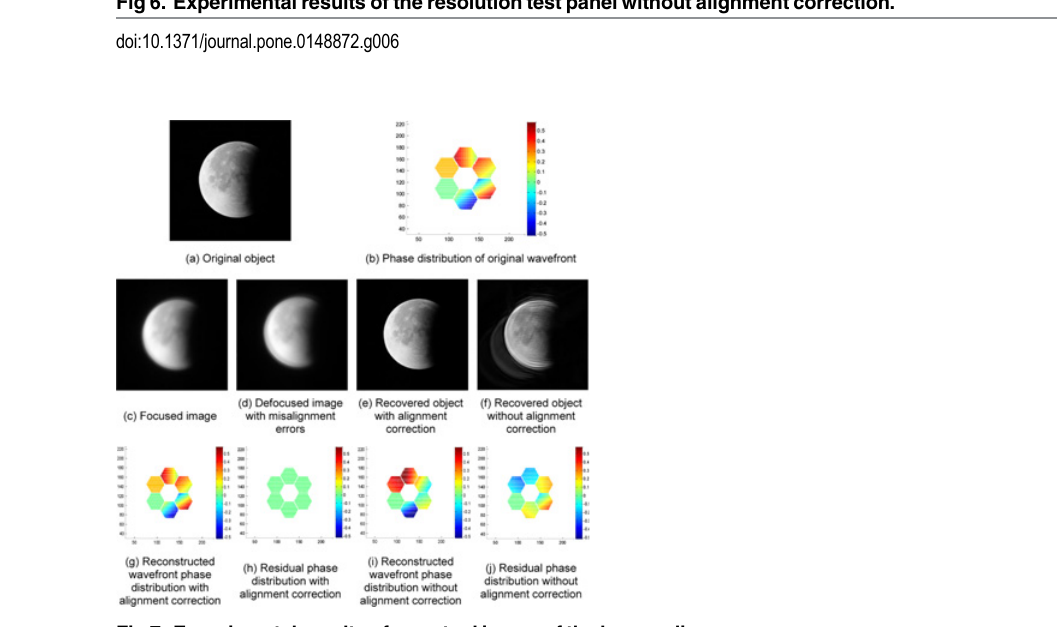
Fig 7. Experimental results of an actual image of the lunar